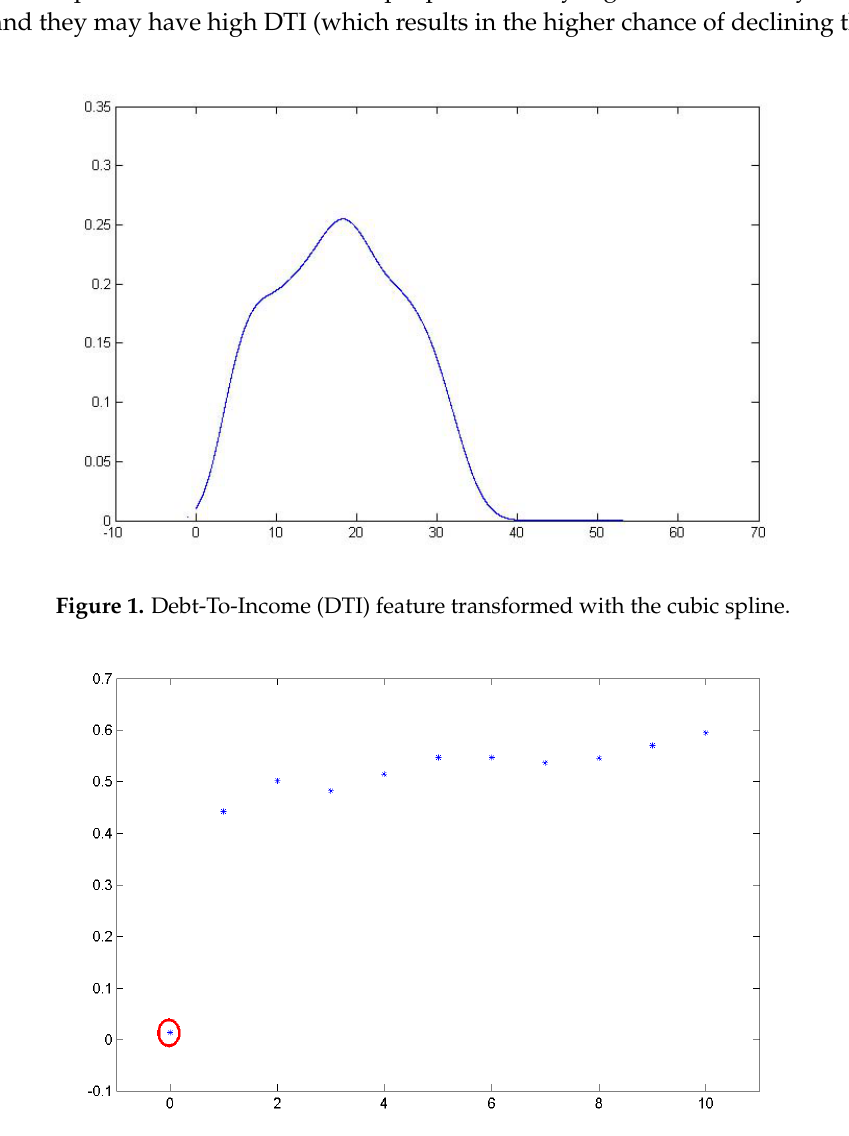
Figure 2. Employment Length feature transformed with the cubic spline. The first observation with distinctively lower value is